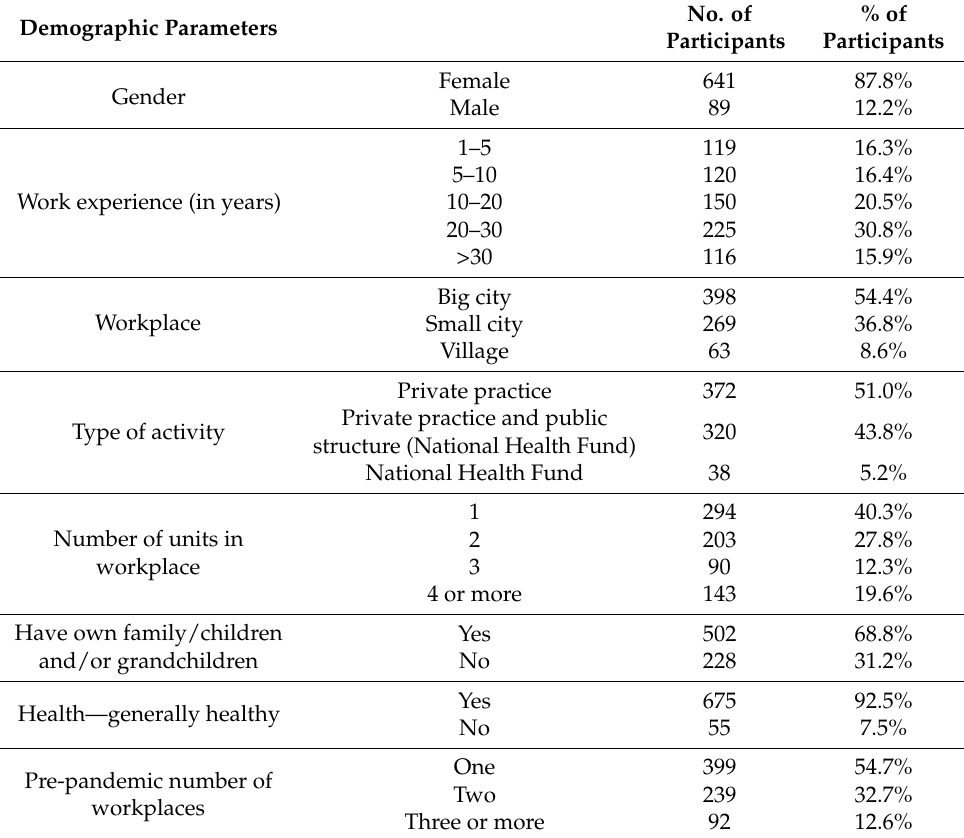
Table 1. Socio-demographic characteristic of